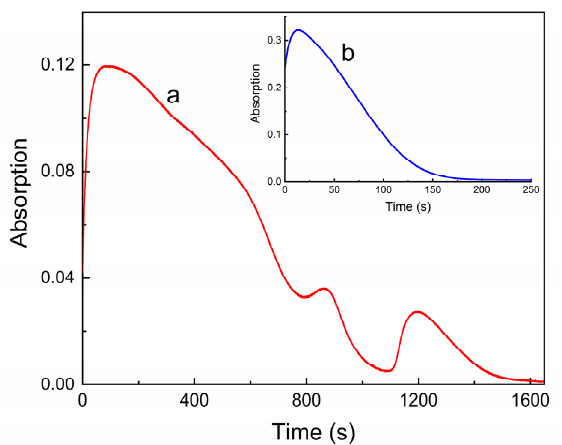
Figure 3. Kinetics of photodegradation of 2 upon UV–irradiation through a UFS–1 light filter ( a ), recorded at 605 nm. The inset shows the kinetics of photodegradation of precursor 1 ( b ).